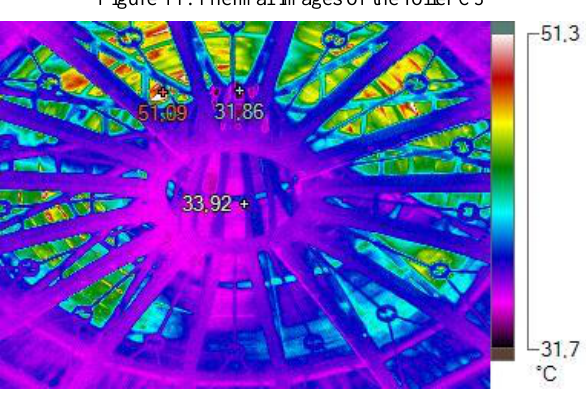
Figure 12. Thermal images of the